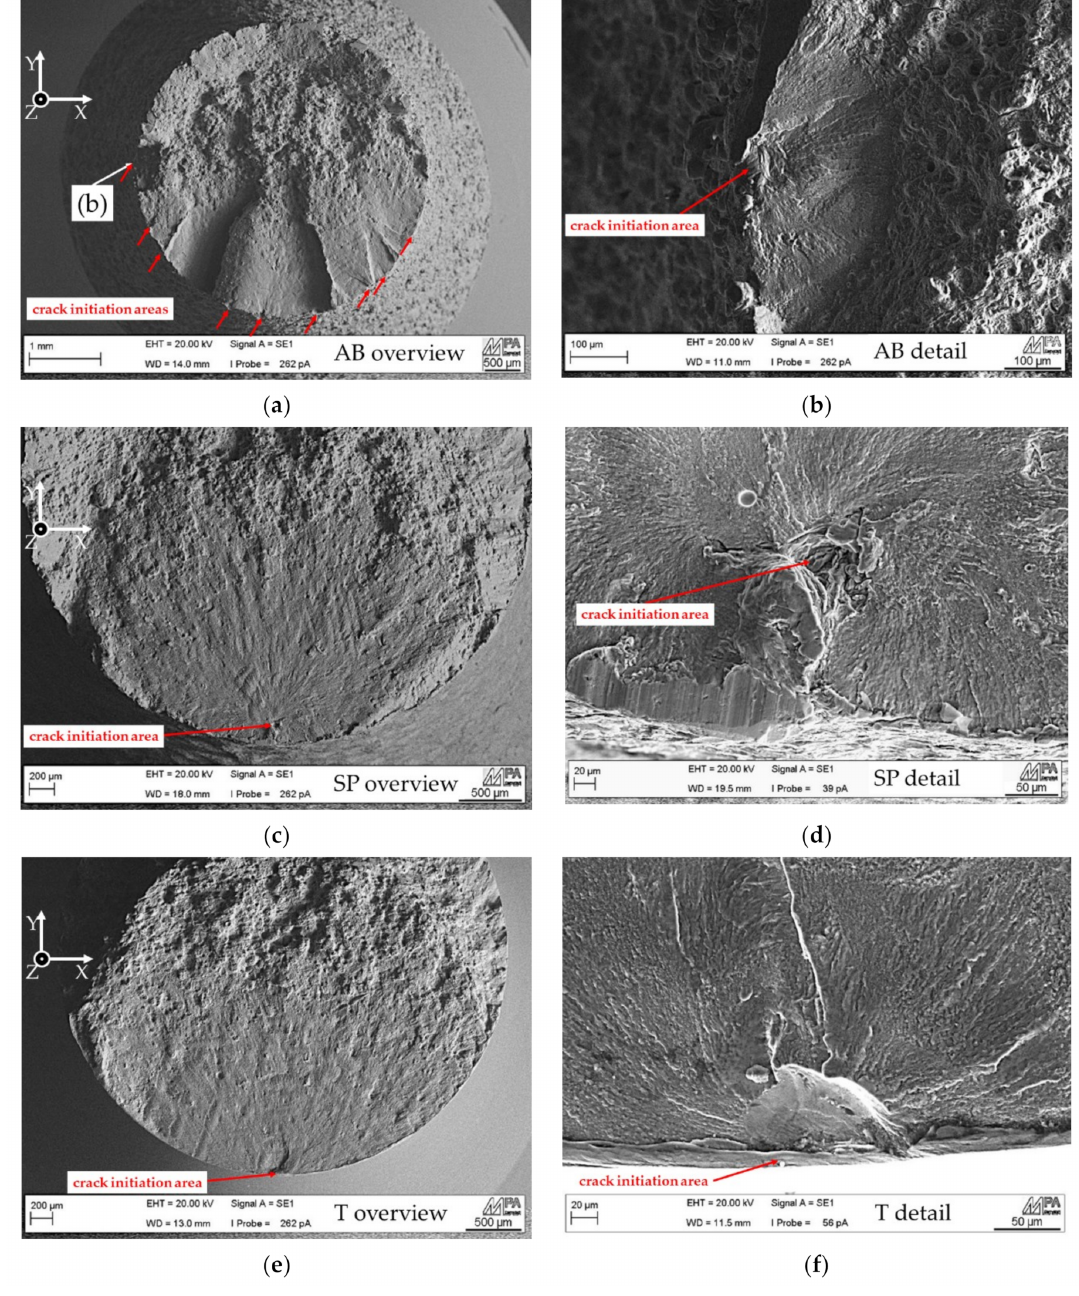
Figure 9. ( a ) Exemplary overview of a fracture surface of an as-built specimen AB. ( b ) AB detailed view of a crack initiation area, ( c ) exemplary overview of a fracture surface of a shot peened specimen SP, ( d ) SP detailed view of the crack initiation area, ( e ) exemplary overview of a fracture surface of a turned specimen T, ( f ) T detailed view of a crack initiation area. All fracture surfaces inside one charge are of similar character, regardless of the stress amplitude. R =